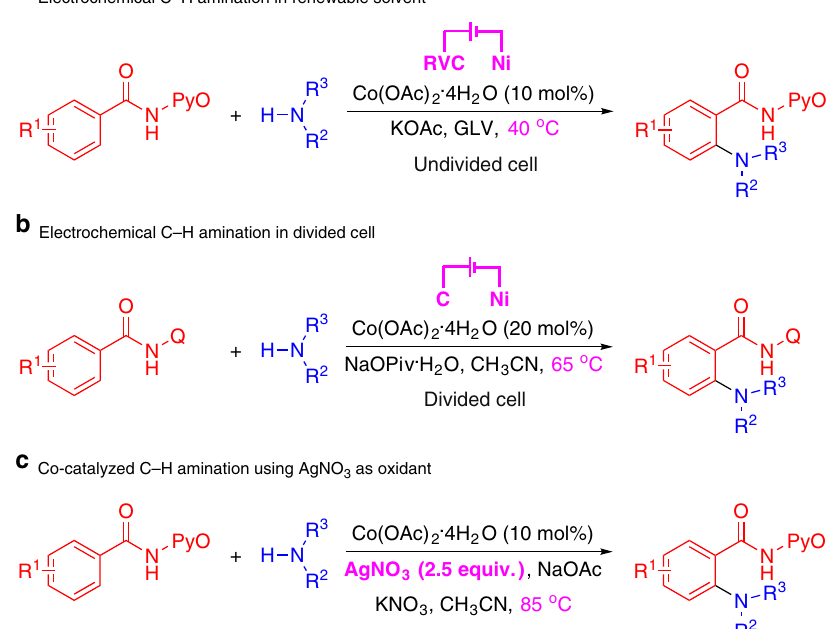
Fig. 1 Oxidative C – H amination of aromatic amides. a Electrochemical C – H amination in renewable solvent. b Electrochemical C – H amination in divided cell. c Co-catalyzed C – H amination using AgNO 3 as oxidant.